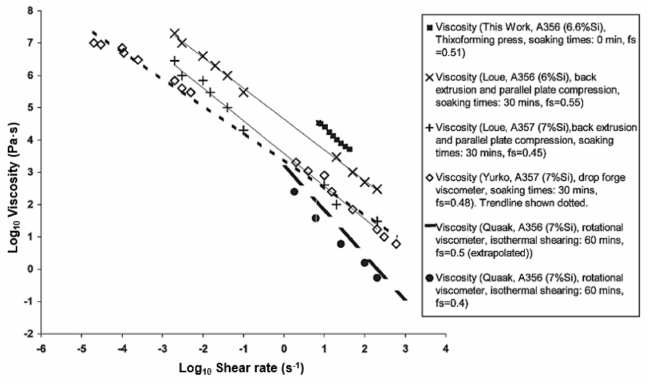
Figure 8. Comparison of apparent viscosities obtained by various experimental techniques and conditions [44].